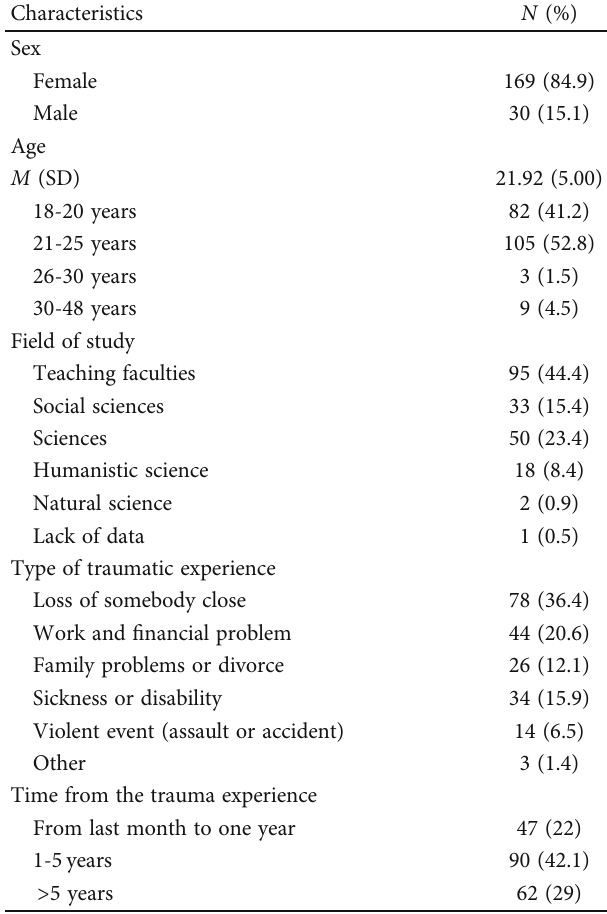
Table 2: Demographic characteristics of participants ( N = 199